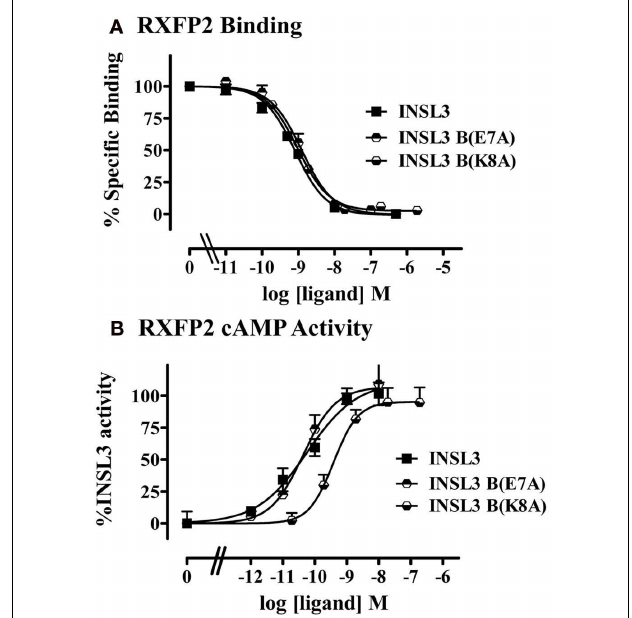
FIGURE 5 |Activity of INSL3A-chain variant peptides on the RXFP2 receptor. (A) Competition binding utilizing Eu-labeled INSL3 compared to INSL3 and H2 relaxin. Data are expressed as the percentage of specific binding and are pooled from at least three experiments with triplicate determinations within each assay. (B) cAMP activity compared to INSL3 and H2 relaxin measured utilizing a pCRE– β -galactosidase reporter gene assay. Data are expressed as the percentage INSL3 maximum activity and are pooled data from at least three experiments with triplicate determinations within each assay.